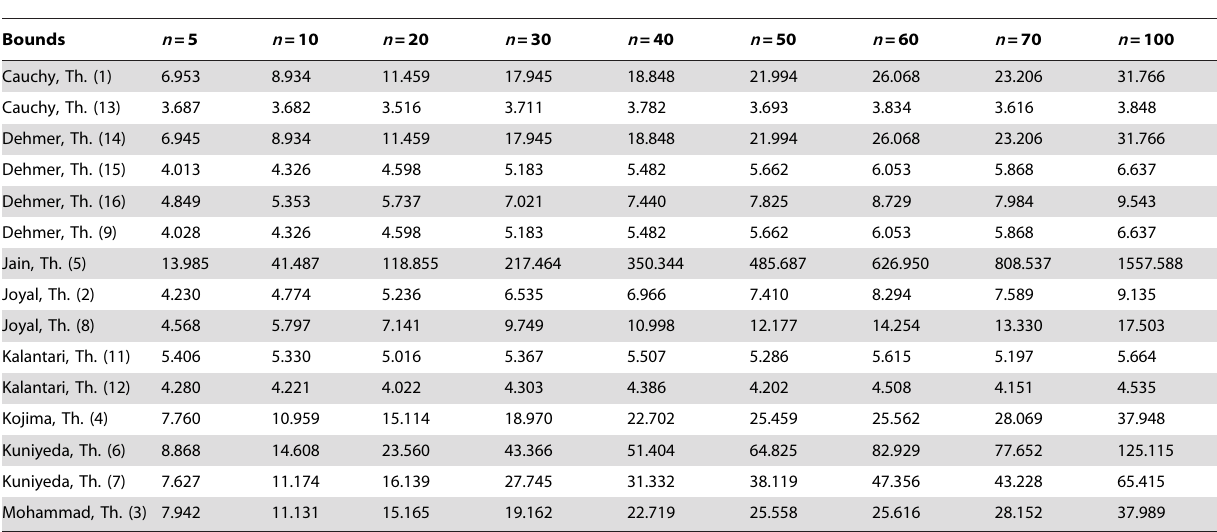
Table 5. Mean bounds values for polynomials P i [ C 5